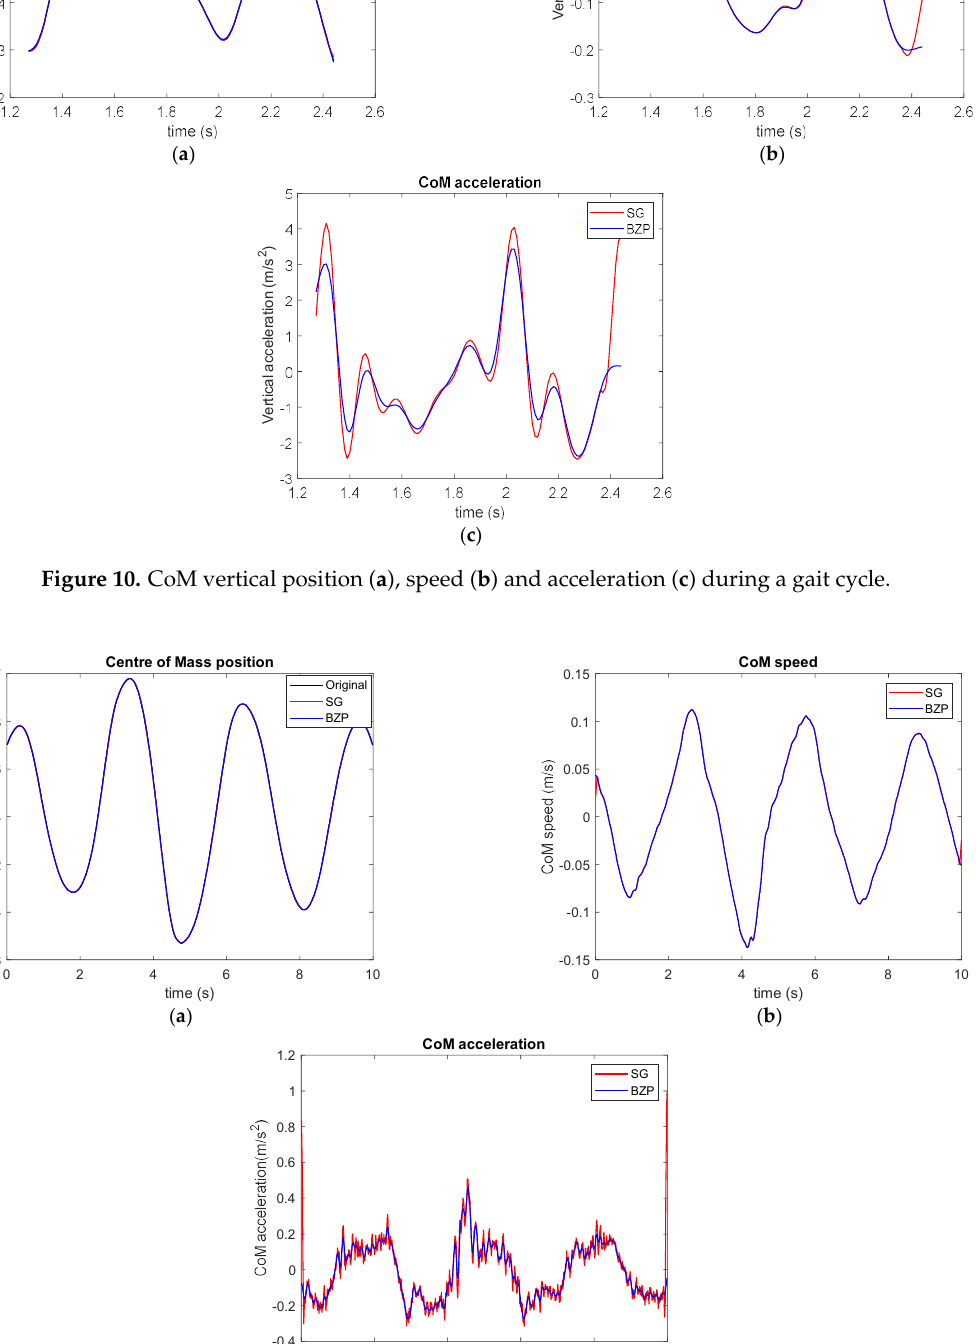
Figure 10. CoM vertical position ( a ), speed ( b ) and acceleration ( c ) during a gait cycle.